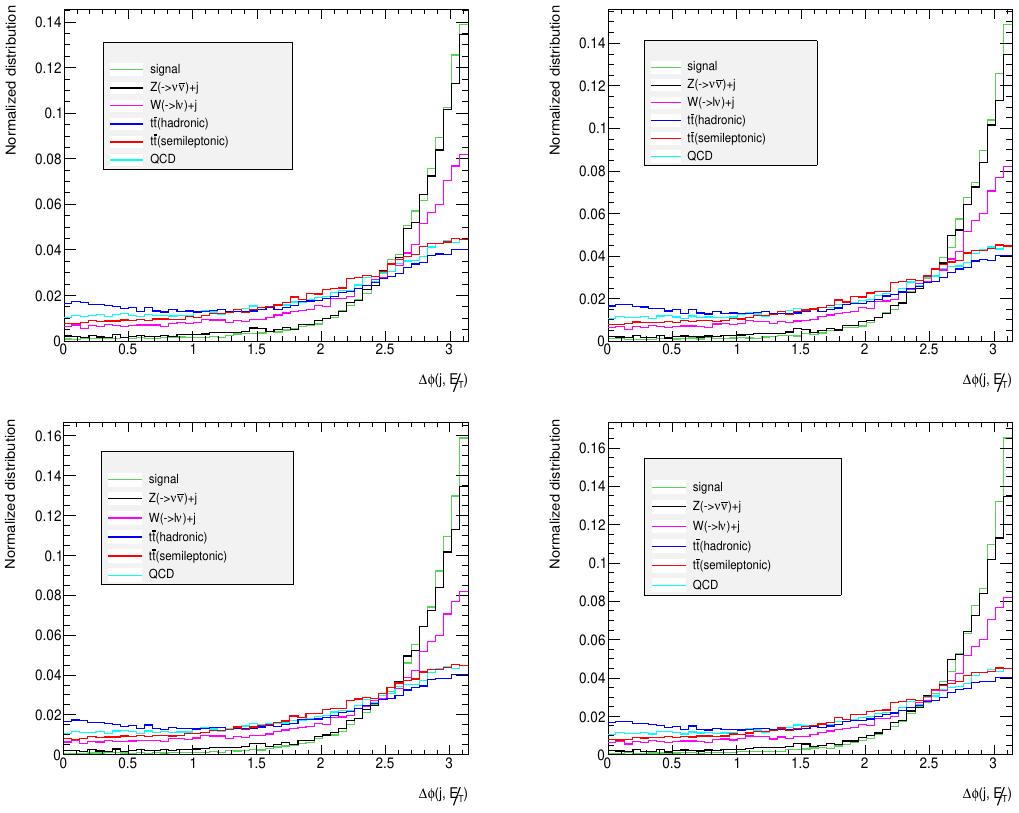
Figure 8 . (cid:1) (cid:30) (jet, =E T ) distribution for gluon fusion signal and background processes, Type I BP I(top left), Type I BP II(top right), Type II BP I(bottom left) and Type II BP II(bottom right).